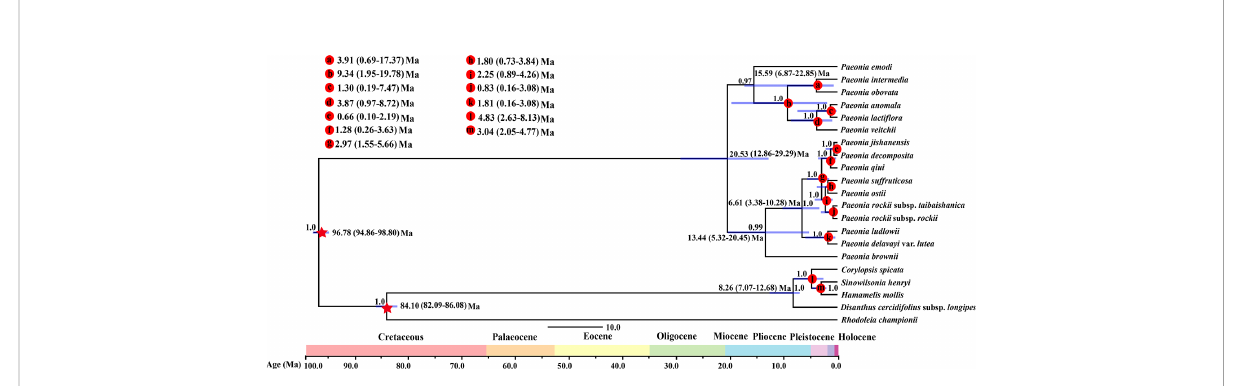
FIGURE 3 Chronogram for the Paeoniaceae species obtained using BEAST based on the plastid genome. The 95% highest posterior density (HPD) credibility intervals for node ages are labeled above the